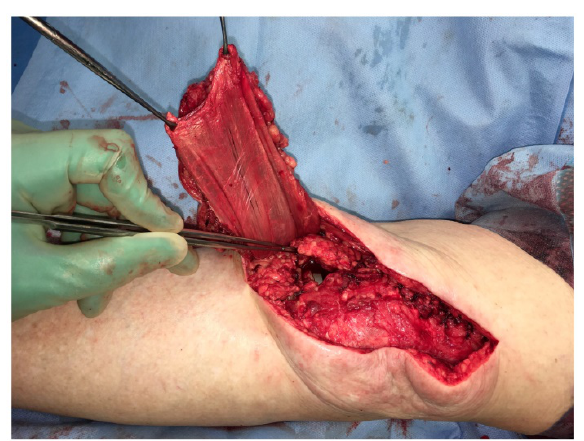
Figure 6: Pedicled MSAP gastrocnemius flap: Left knee with combined 40% patellar tendon and medial capsule lesion during the second stage of a two-stage procedure. Initial wound dehiscence after primary TKA had been treated with NPWT. Note the tendinous back of the medial gastrocnemius muscle already in place for medial capsule/patellar tendon strengthening (Table 1: Patient No. 5; additional Figures 12, 13, 14, 15, 16,